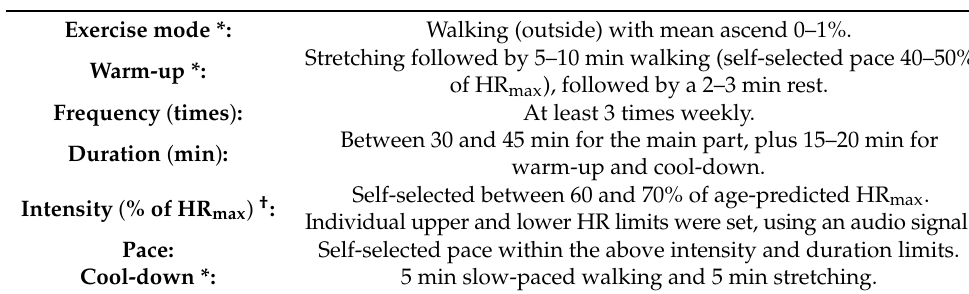
Table 2. Walking arm guidelines.